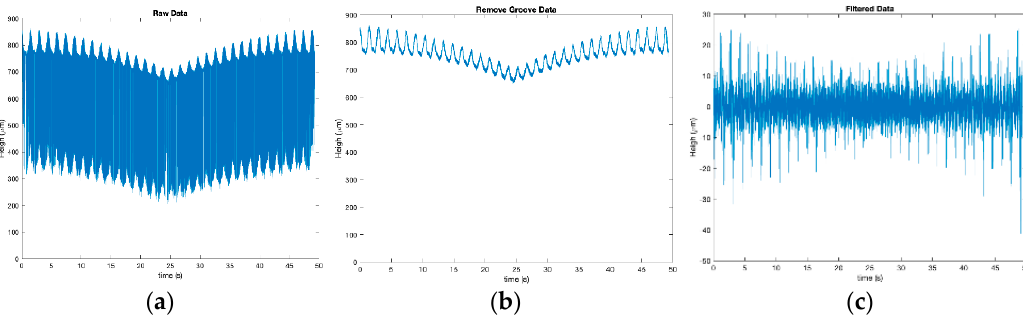
Figure 4. Measurement data of pad surface. ( a ) Raw data combined with arm tilting, pad waviness and asperities. ( b ) Extraction of pad surface profile. ( c ) Extraction pad asperities.